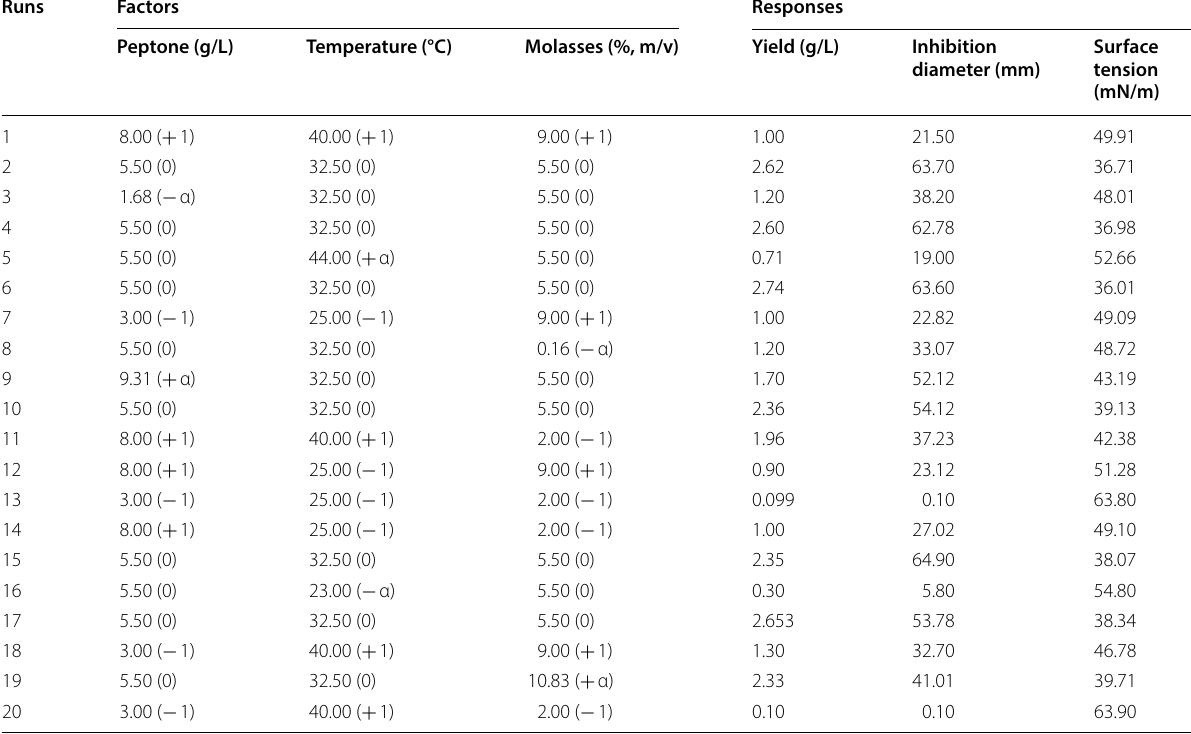
*() indicates the coded values of the different